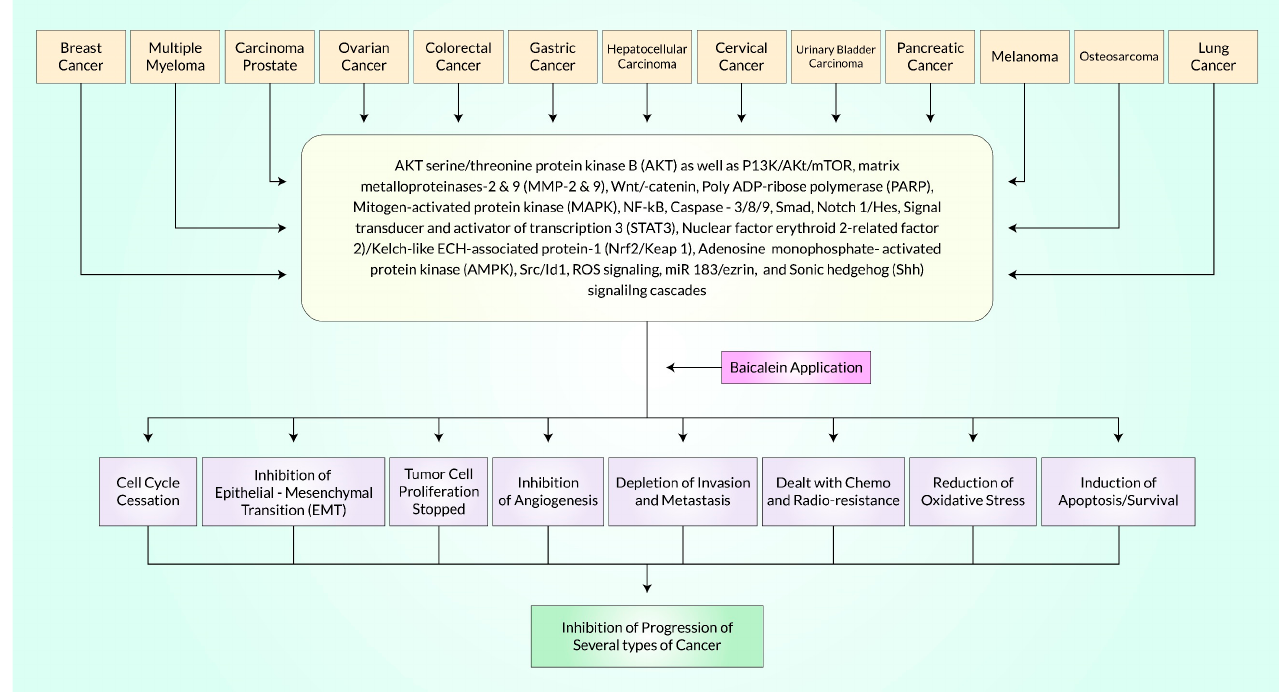
Figure 6. Baicalein can limit the growth of various malignancies by binding to and interacting with many different molecular targets. These cellular points, which play a role in preventing multiple malignancies, are presented here. This figure was updated and modified after Liu et al. [30]. The impressive therapeutic properties of Baicalein, such as its angiogenesis inhibi- tion, inflammatory process blocking, invasion prevention, counter-metastasis, and anti- oxidant, contra-proliferative, and apoptotic activities, have been demonstrated by numer- ous investigations by targeting multiple pathways, including ERK/MAPK, Wnt/-catenin, and PI3K/Akt/NF- κ B [74,88,100]. Baicalein has also been shown to inhibit breast cancer